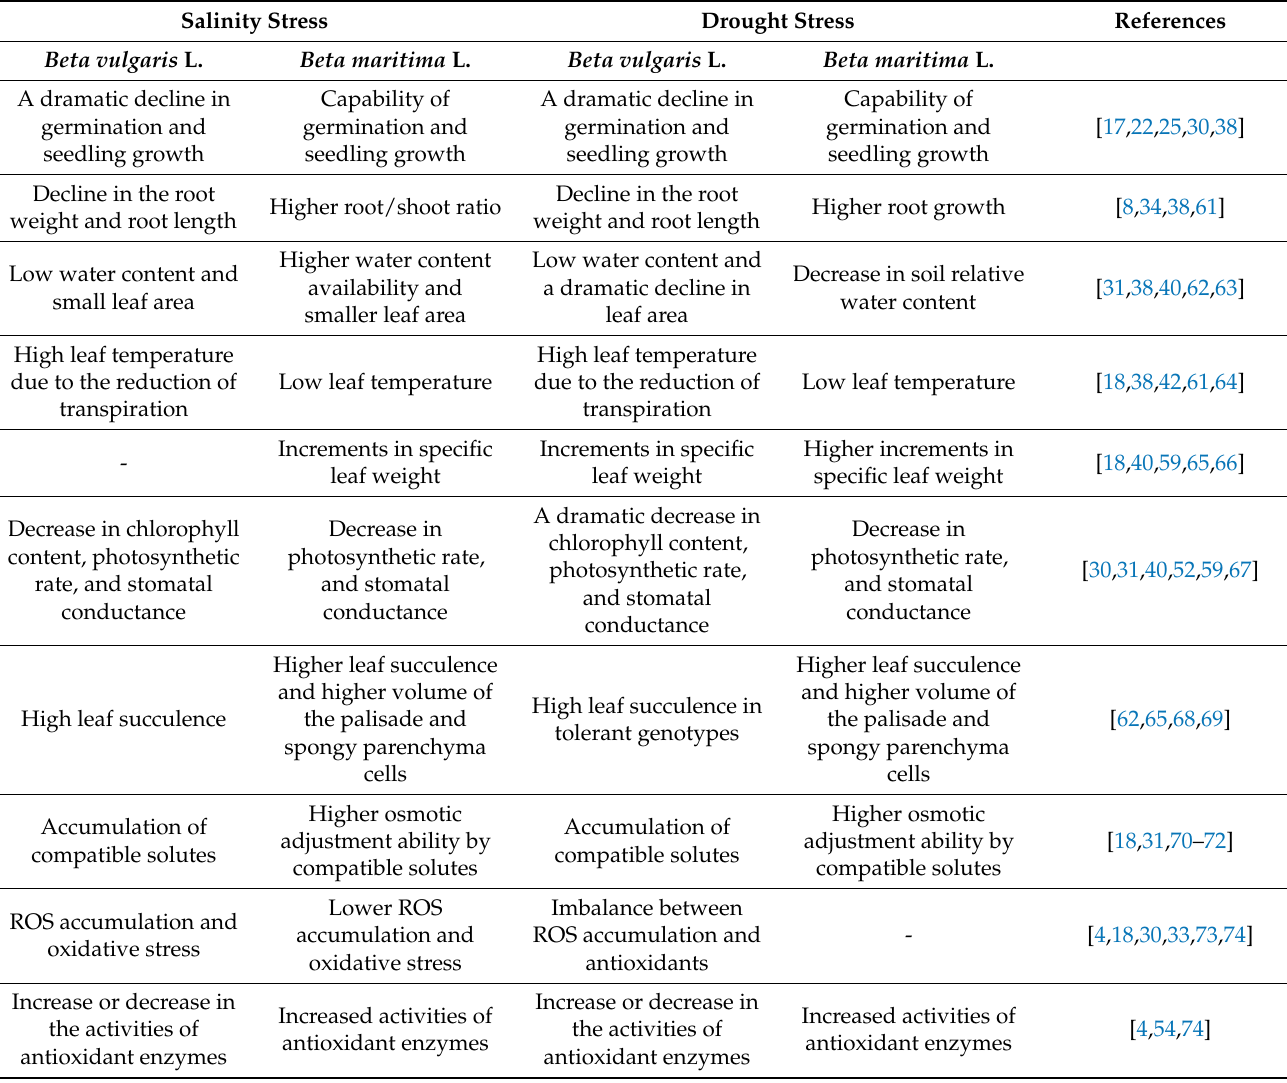
Table 1. A brief summary of the effects of salt and drought stress on cultivated beets ( B. vulgaris L.) and wild beet ( B. maritima L.) at morpho-physiological and biochemical levels. Beta vulgaris (cultivated beets) includes sugar beet, fodder beet, red beet, and chard. Salinity Stress Drought